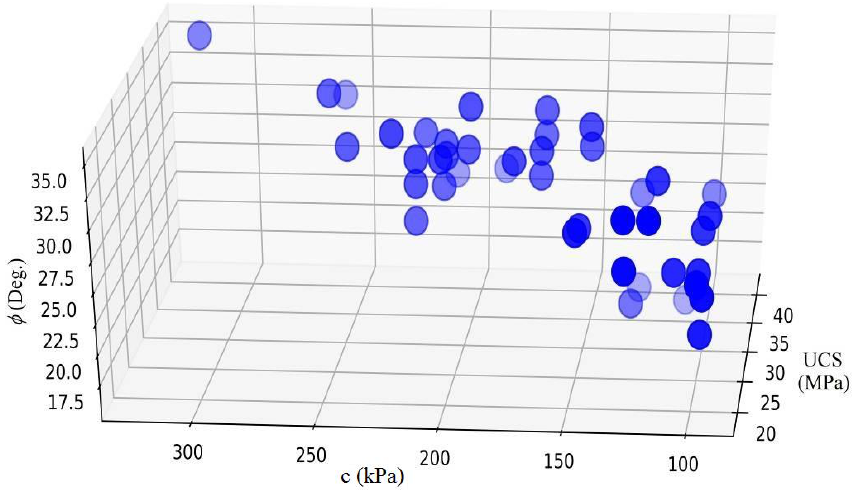
Figure 9. Variation chart for geotechnical parameters.